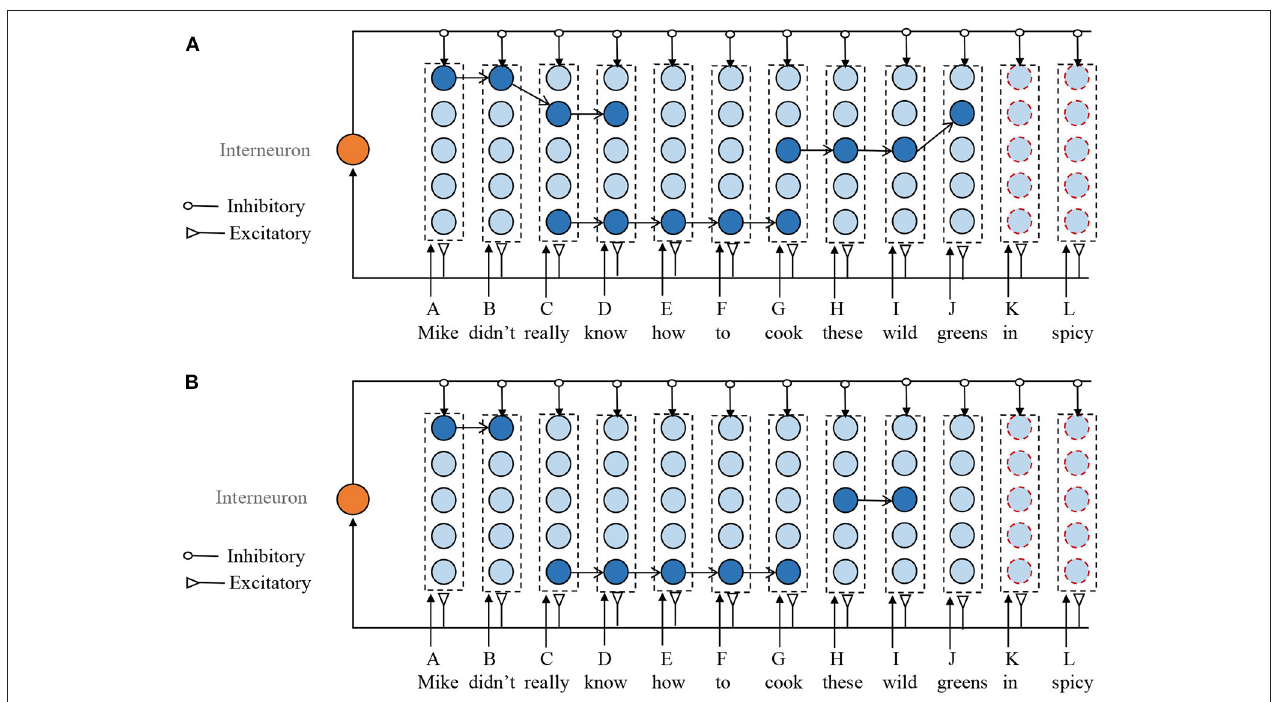
FIGURE 4 | Illustration of the sequence storage process. It mainly consists of three steps. (1) Add new mini-column to represent the unseen memory items. (2) Obtain several ROEs without overlapping. (3) Update the synaptic efficiency according to the STDP learning rule. (A) Overlapped ROEs. (B) ROEs without overlap. For clarity, the weak connections are not shown in this